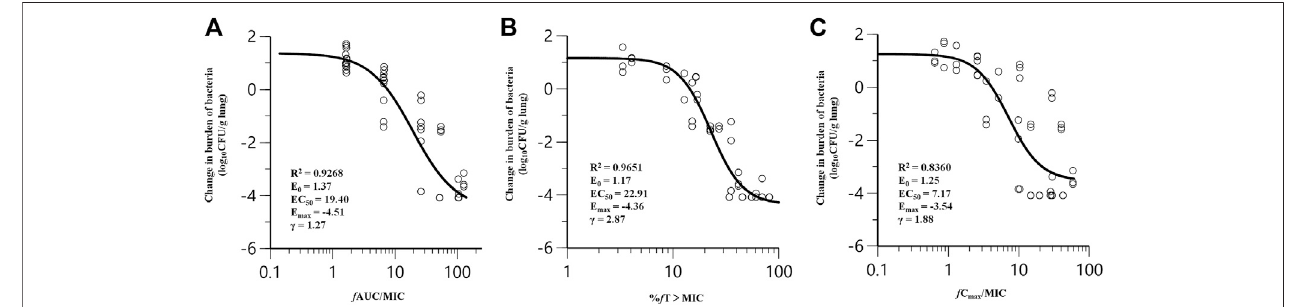
FIGURE2| Correlationofpharmacokinetic/pharmacodynamic (PK/PD)indices f AUC 0-24 /MIC (A) ,% f T > MIC (B) and f C max /MIC (C) withef fi cacyfornemonoxacin in a neutropenic murine lung infection model caused by Streptococcus pneumoniae ATCC49619 in dose-fractionation study. Treatment was initiated at 2 h postinfection. Nemonoxacin was subcutaneously administered with a dosing range of 1.25 – 80 mg/kg, in once daily (q24h), twice daily (q12h), three times a day (q8h) and four times a day (q6h). Each circle represents data for each mouse. R 2 , the square of the correlation coef fi cient.